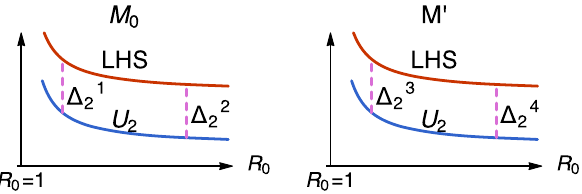
Fig. 1 Entropic uncertainty (LHS) and lower bound U 2 using acces- sible information for black hole with mass M 0 and M (cid:4) . Δ 1 Δ 3 = Δ 4 where Δ 1 and Δ 2 correspond to different relative distance 2 2 2 2 R 0 = r 0 / 2 M from event horizon. As shown above, at event horizon R 0 = 1. It is sufficient to conduct experiments near one Schwarzschild black hole with mass M 0 to obtain LHS. For any other Schwarzschild black holes with mass M (cid:4) , we can precisely predict its LHS using LHS for M 0 , Δ 2 and U 2 for M